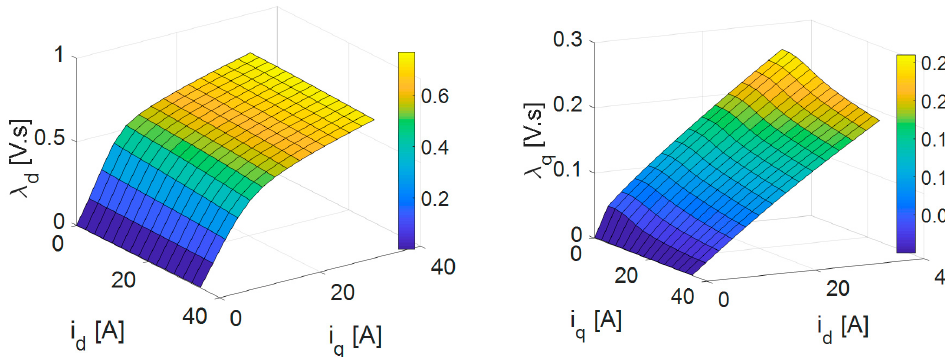
Figure 7. Flux-linkage components of the FMSynRM against the current components.